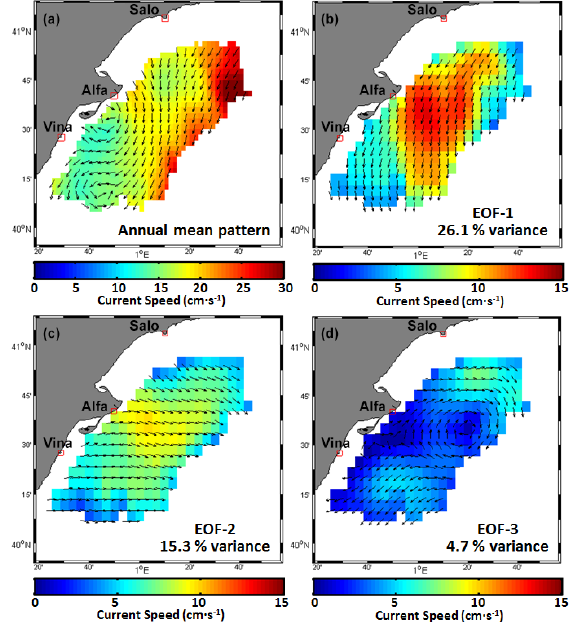
Figure 10. Spatial patterns of the (a) annual mean velocity field and (b) first, (c) second and (d) third EOF dominant modes of un- filtered hourly radar surface currents for 2014. Current vectors were plotted in every second grid point for clarity. Variance explained is indicated in the lower right corner of the corresponding panel.